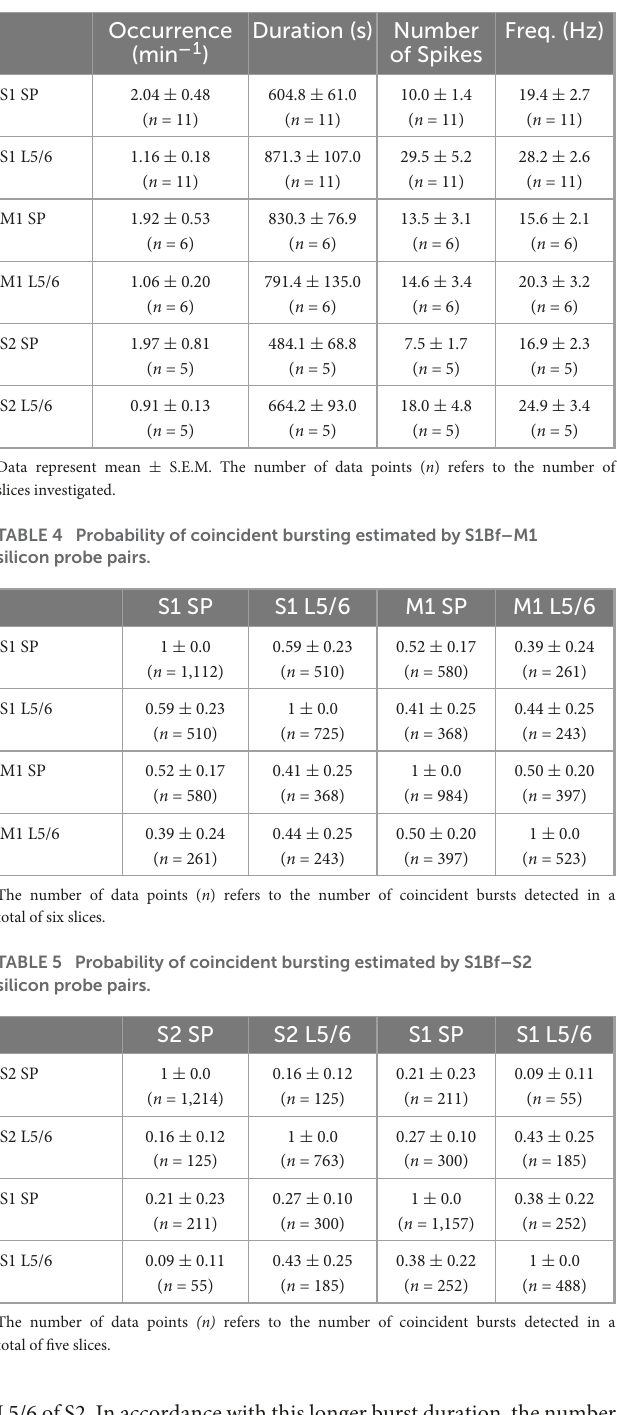
L5/6 of S2. In accordance with this longer burst duration, the number of spikes per burst were in S1Bf L5/6 (30 ± 5) significantly ( p < 0.5) higher than in the other regions and layers (between 8 ± 2 and 18 ±